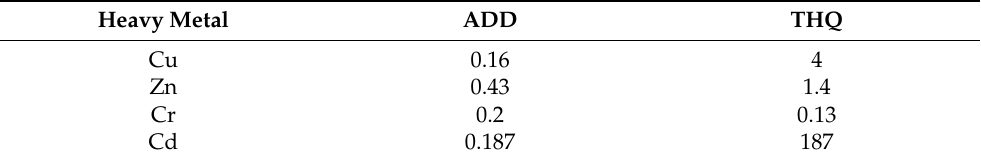
Table 3. Average Daily Dose (ADD) and Target Hazard Quotient (THQ) at MANASE WWTP. Heavy Metal